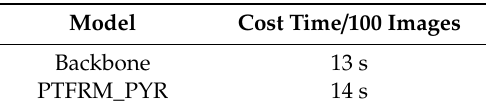
Table 6. The processing speed of each